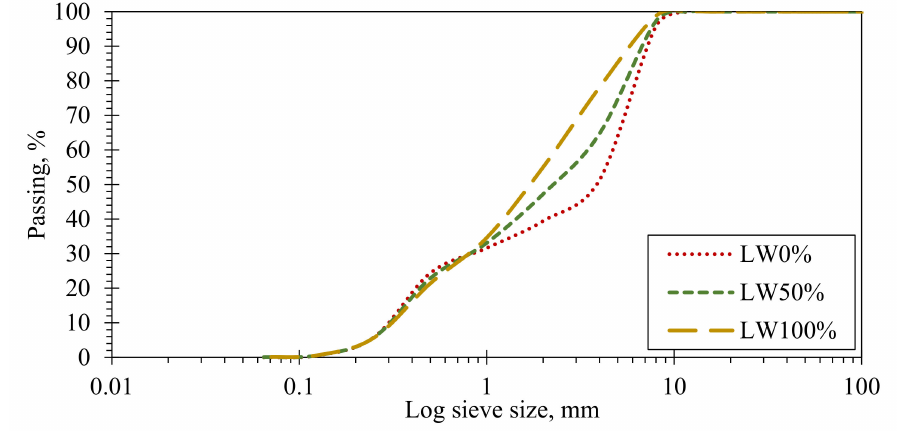
Figure 1. Sieve analysis for produced aggregate blends.